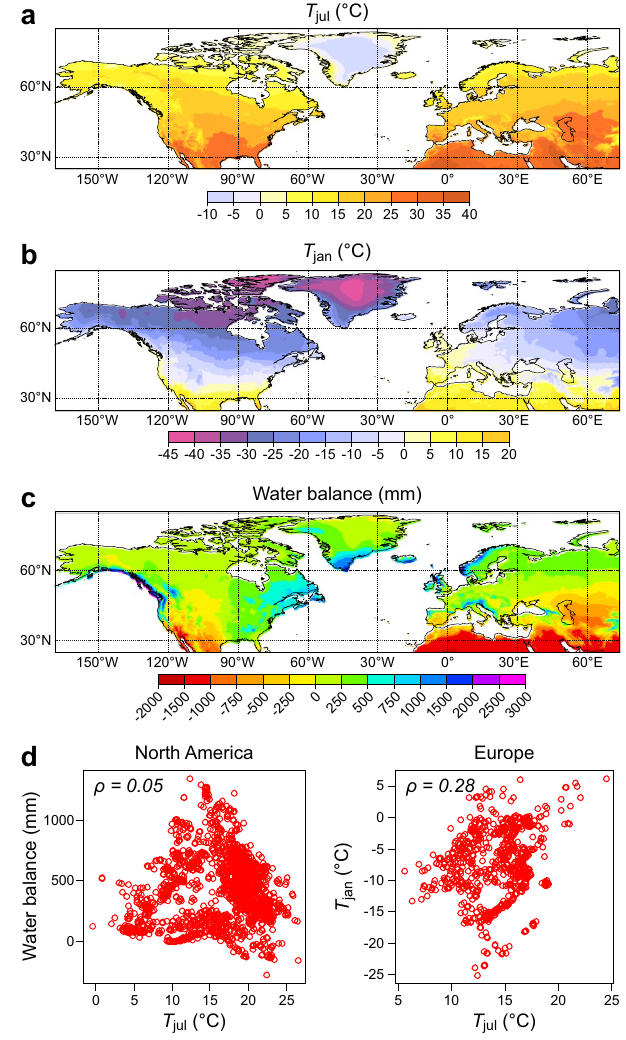
Figure 2. Spatial distribution and correlation of reconstructed variables. The maps show the modern values for ( a ) July mean air temperature ( T jul ), ( b ) January mean air temperature ( T jan ), and ( c ) Annual water balance. Panel ( d ) shows observed values and the Spearman correlation ( ρ ) for the reconstructed climate variables for the European and North American pollen–climate calibration